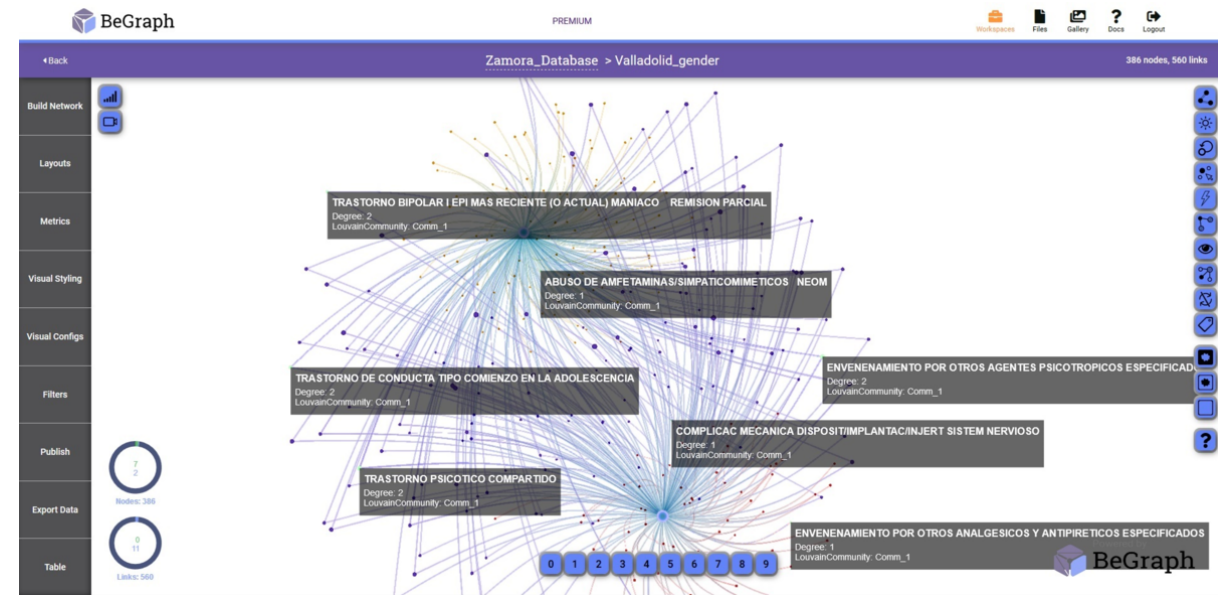
Figure 4. Network with prevalent diseases-gender in the University Clinic of Valladolid.